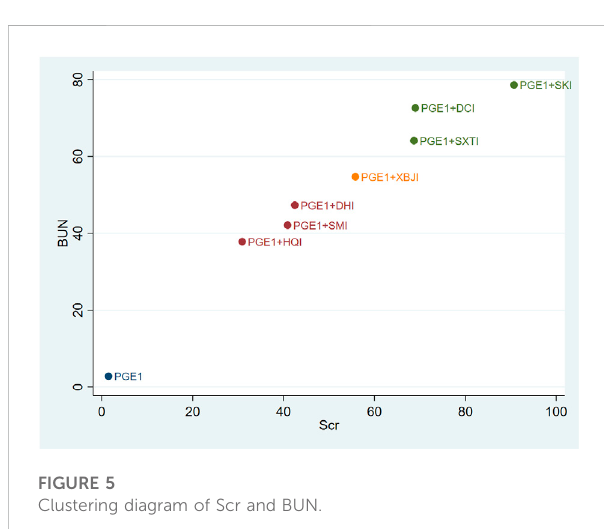
FIGURE 5 Clustering diagram of Scr and BUN.